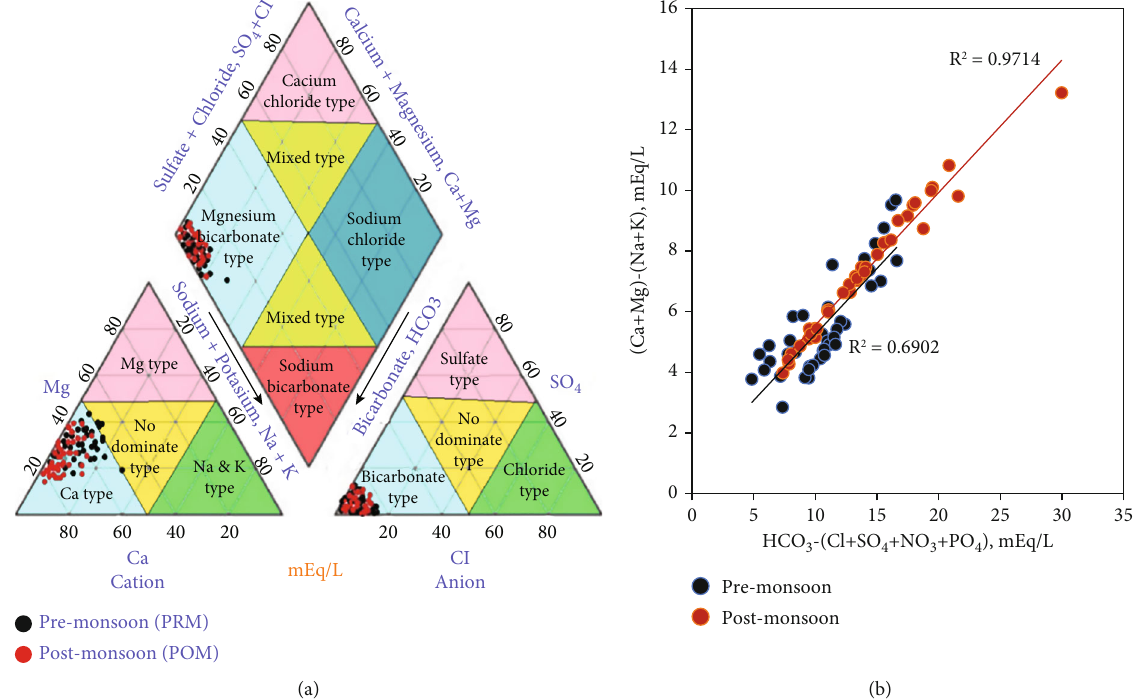
Figure 4: (a) Piper diagram and (b) Chadha ’ s plot for groundwater classi fi